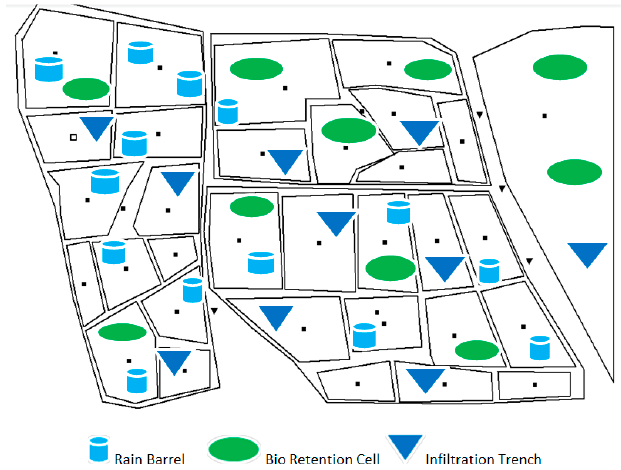
Figure 4. Configuration of various LID techniques and distributions. Table 4. Different land use types and areas within the study area.